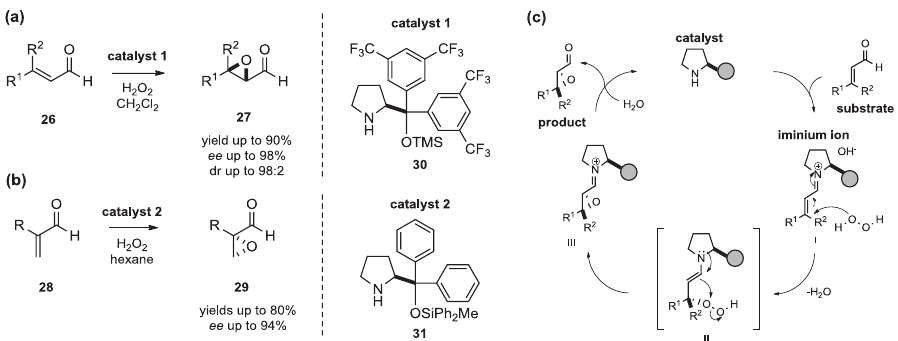
Figure 8. Two examples of catalytic enantioselective epoxidation of enals. (a) from Ref. [36], (b) from Ref. [37] and (c) hypothesized mechanism.